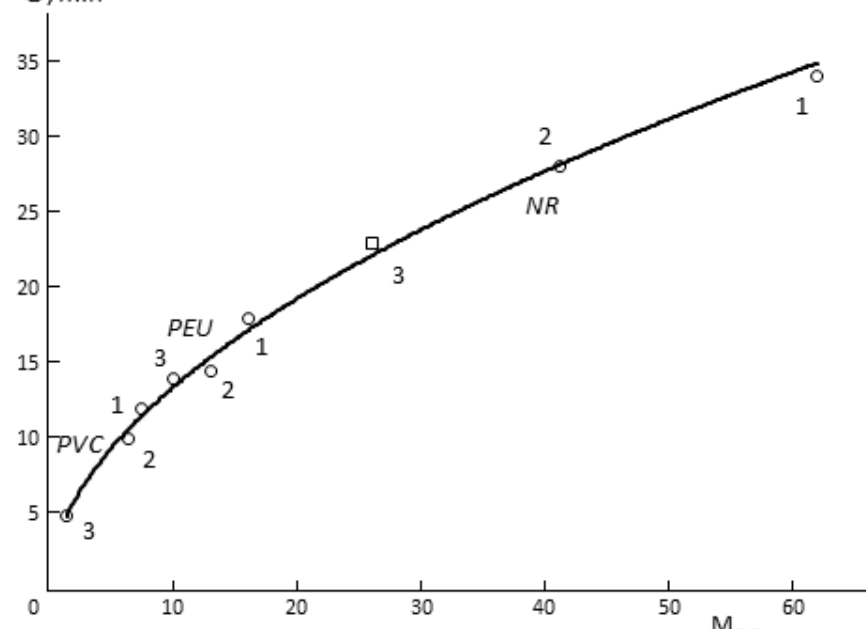
Figure 4. Dependence of the delay time ( Θ ) on the sorption capacity of the porous polymeric membranes (M ∞ ) at 298 K, relative humidity of 30% at various values of relative humidity di ff erences: ( 1 ) 44–90 p / p 0 ; ( 2 ) 44–80 p / p 0 ; ( 3 ) 44–60 p / p 0 . Polymer materials are denoted on the graph.